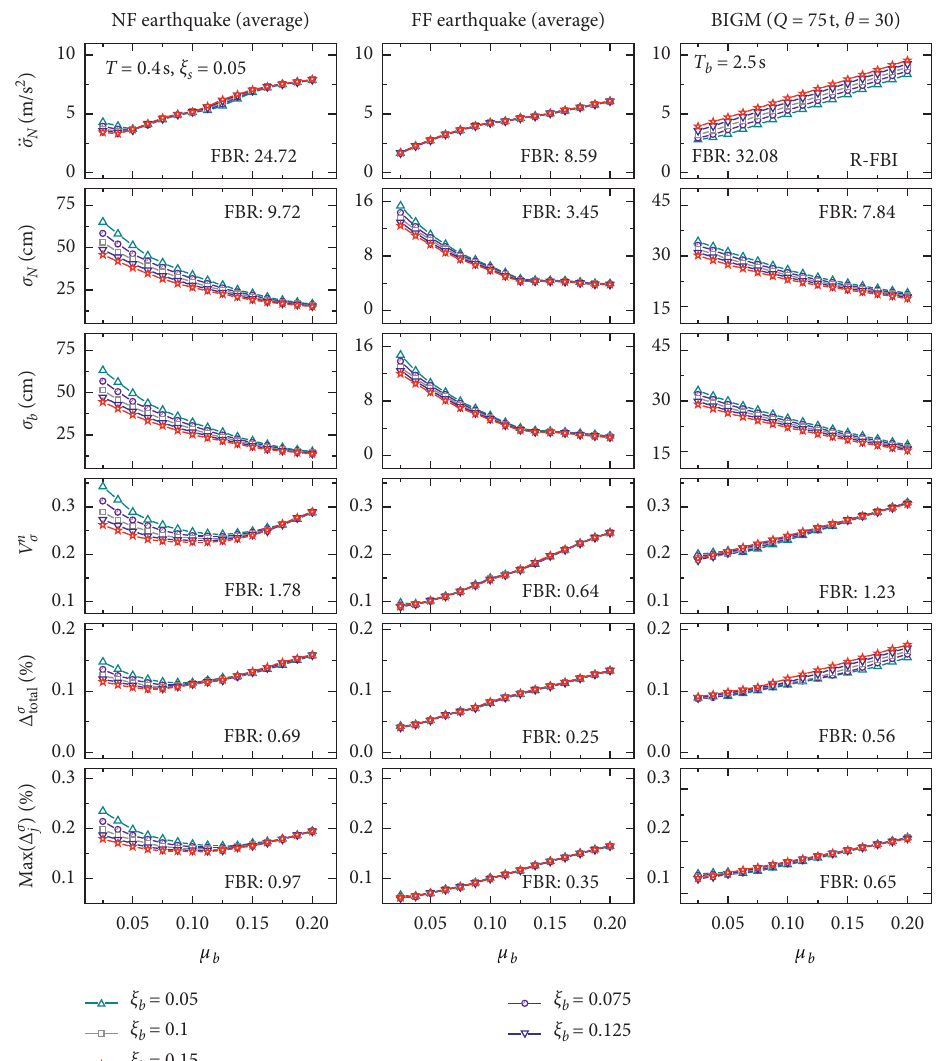
Figure 13: The effect of the friction coefficient of the isolator ( μ building isolated by the R-FBI system under earthquake and